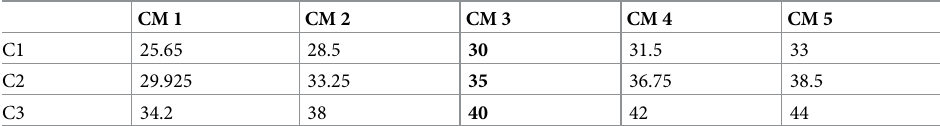
Table 7. CM variable for sensitivity analysis–case 1.